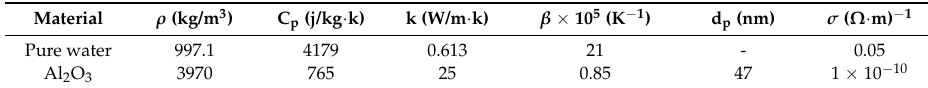
Table 2. Properties of water and